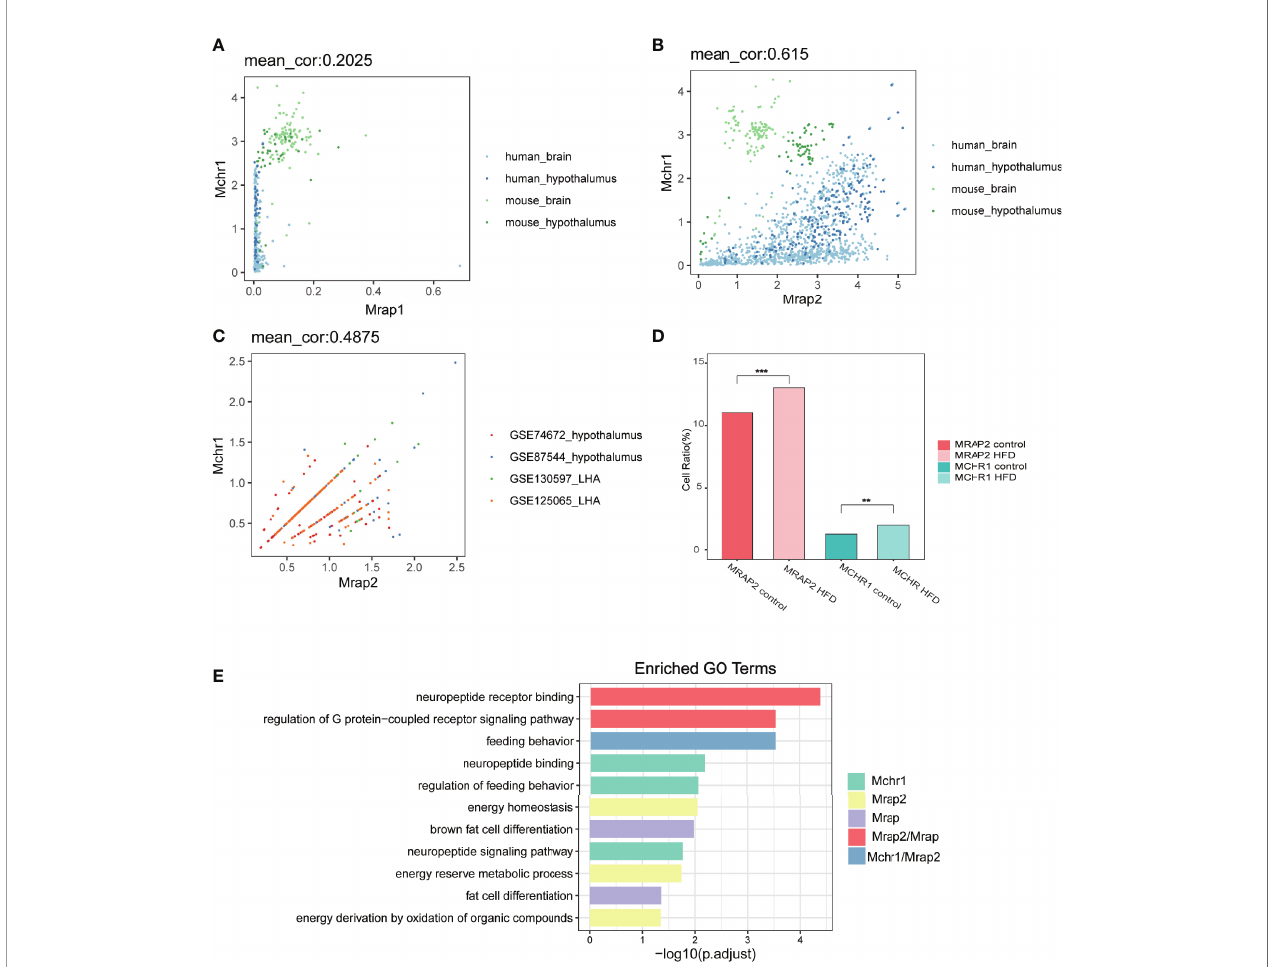
FIGURE 1 | Co-expression and functional analysis of MCHR1 and MRAP proteins in human and mouse RNA-seq datasets. (A, B) Co-expression correlation analysis of MRAP1 (A) or MRAP2 (B) with MCHR1 from the bulk RNA-seq data of human or mouse brain and hypothalamus. (C) Correlation coef fi cient between MRAP2 and MCHR1 from four single-cell RNA-seq datasets of mouse hypothalamus. (D) Changes in cell proportion of MCHR1 and MRAP2 in different metabolic states. One-way ANOVA with post-hoc Tukey test. **p < 0.01, ***p < 0.001. (E) GO enrichment pathway analysis of MCHR1 and MRAP